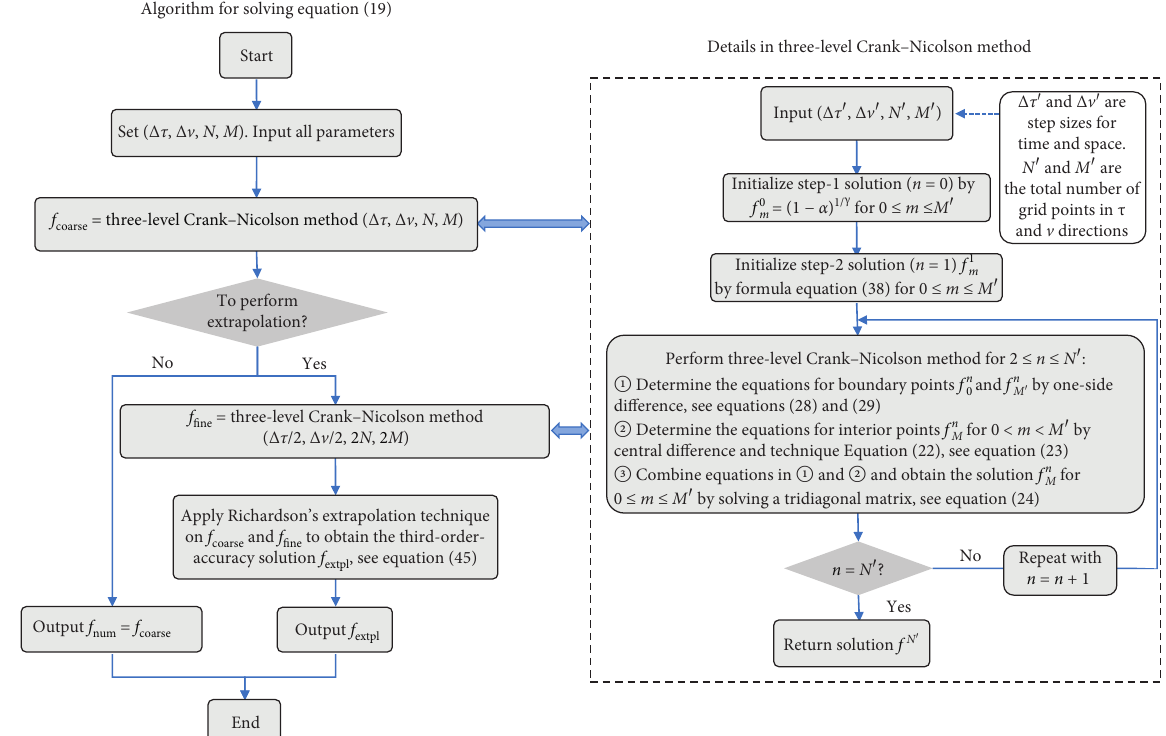
Figure 1: Flowchart of the